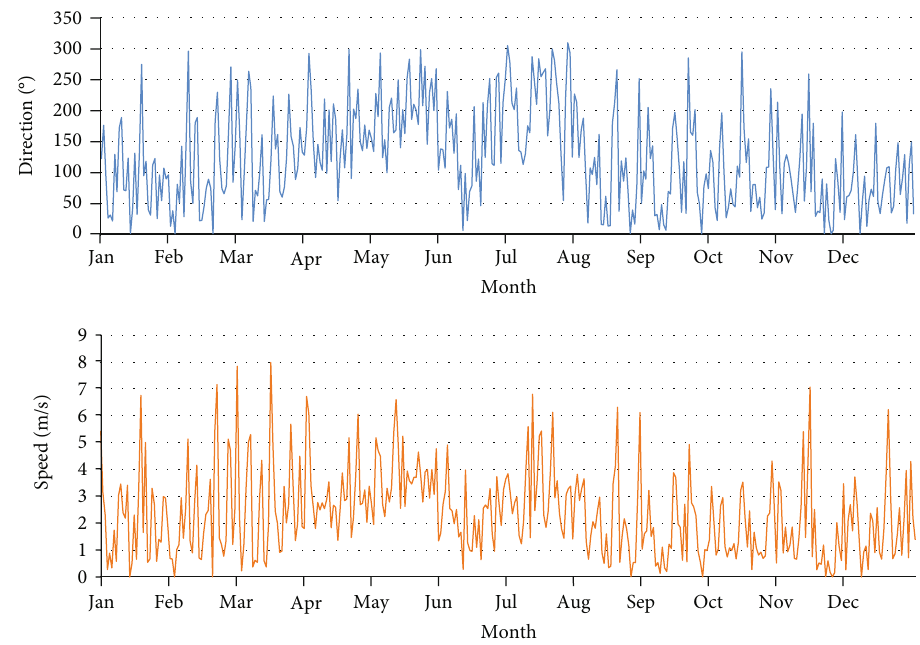
Figure 7: Relative wind speed and annual wind direction around the modeled